Question: What direction does the quantity move in — increasing or decreasing?
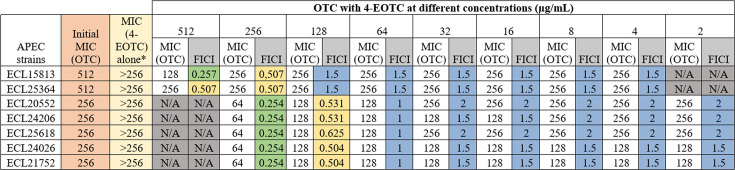
Answer: increasing